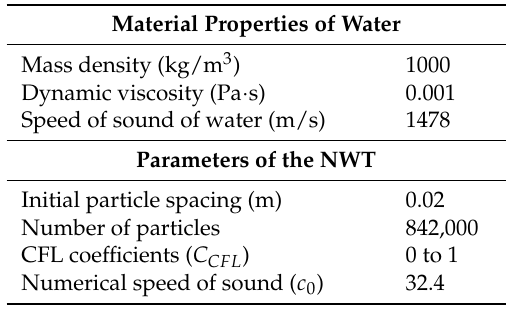
Table 2. Material properties of particles and detailed parameters of the numerical wave